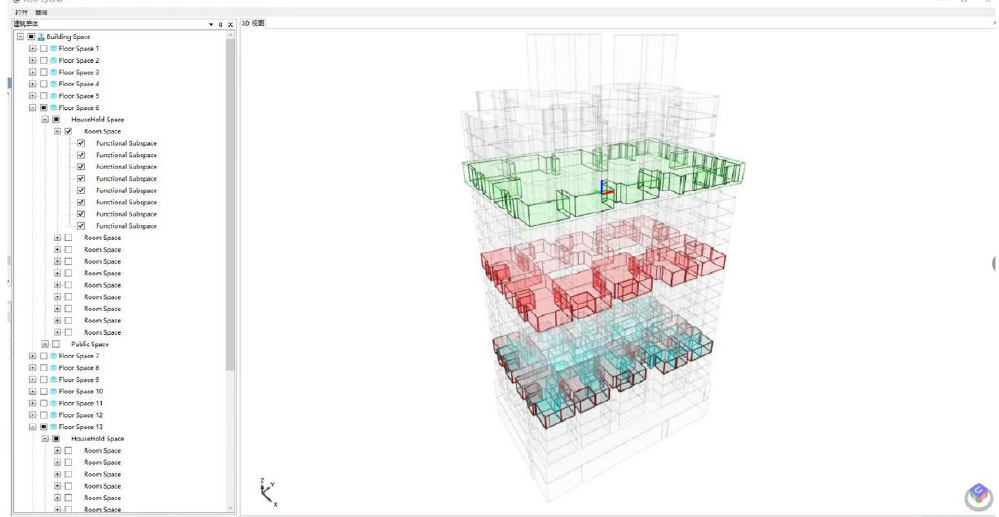
Figure 17. Indoor space classification system.